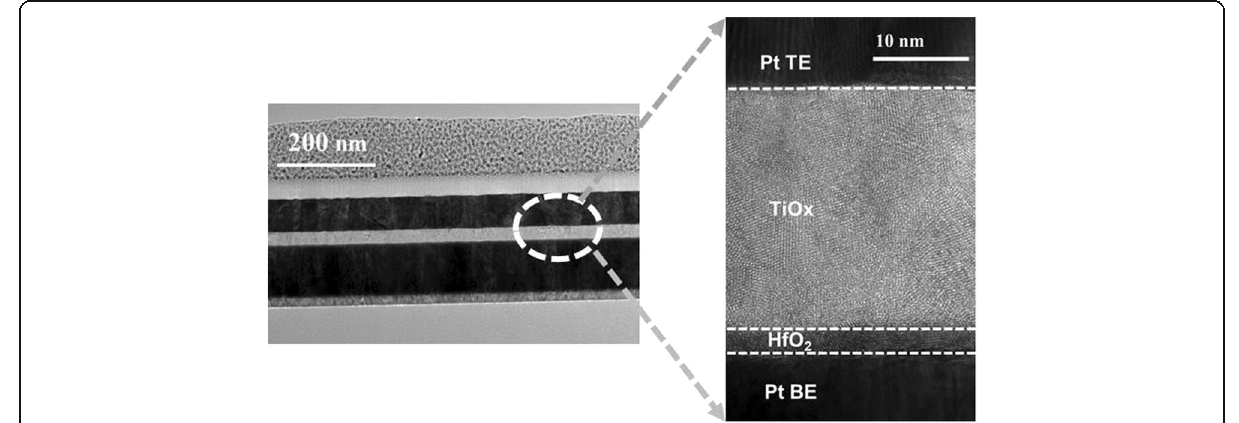
Fig. 2 TEM cross-sections of the Pt/HfO 2 /TiO x /Pt